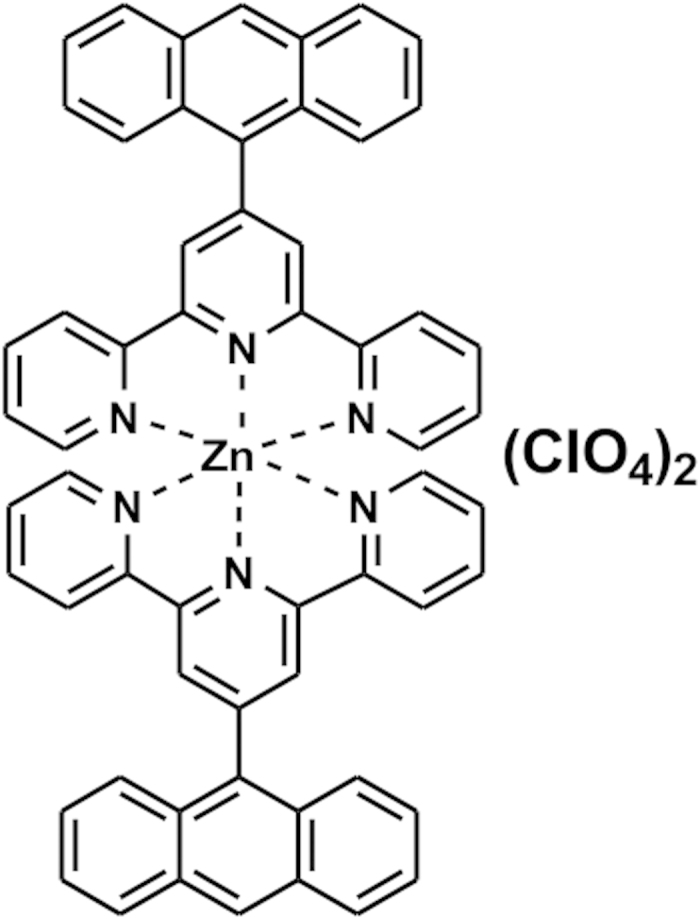
Line representation of the Zn2+ complex of anthracenyl terpyridine9.